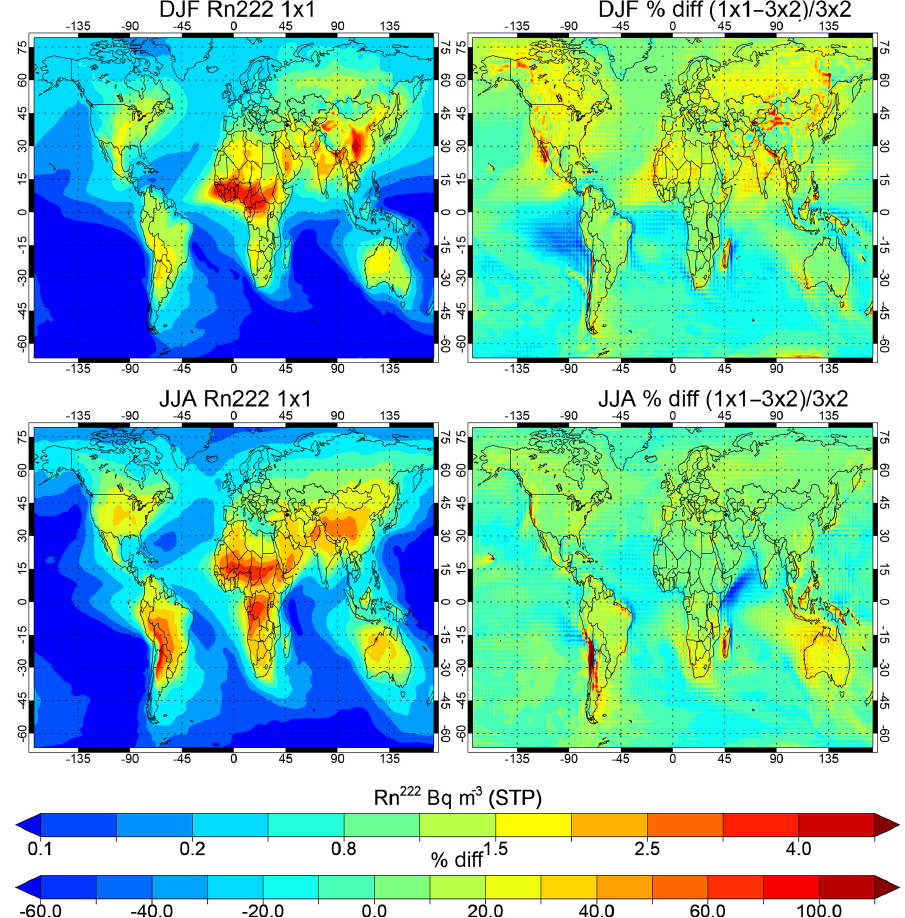
Figure 1. The seasonal distributions of Rn 222 averaged between 800 and 900hPa for DJF (top) and JJA (bottom) for the 3 ◦ × 2 ◦ (left) and 1 ◦ × 1 ◦ (right) simulations, with the associated percentage differences when compared against the 3 ◦ × 2 ◦